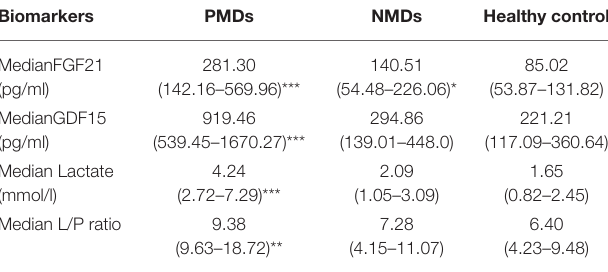
TABLE 1 | Values of biomarkers in the different groups (95%